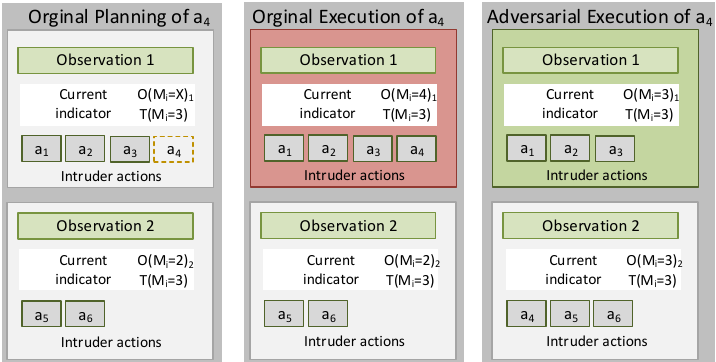
Figure 2. Locality-based mimicry by action